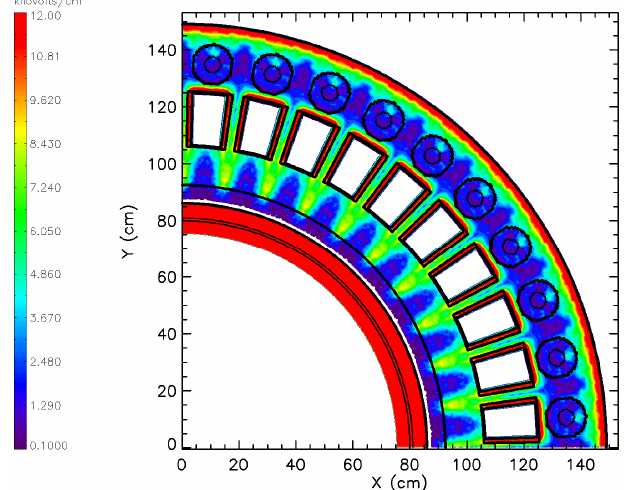
FIG. 6. (Color) Electric field magnitudes from the 3D LSP simu- lation model of a single cavity that includes all 40 bricks. The plot here is for the z ¼ 13 cm plane and shows one-quarter of the total azimuthal extent of the simulation